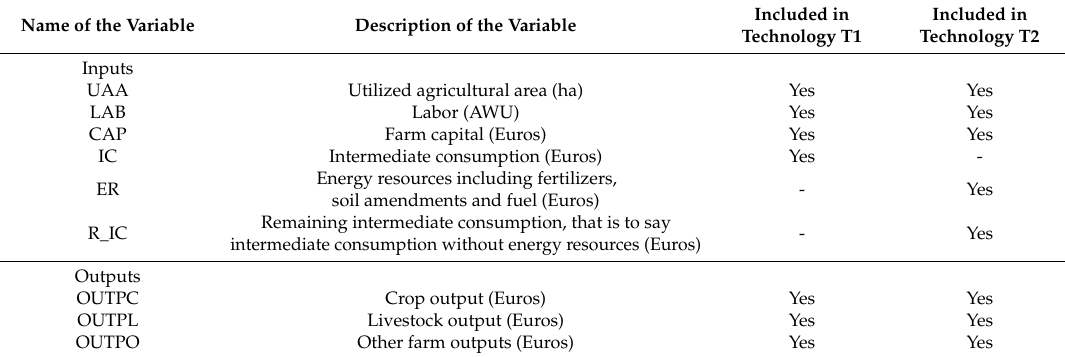
Table 1. Description of output and input variables used to calculate technical efficiency and